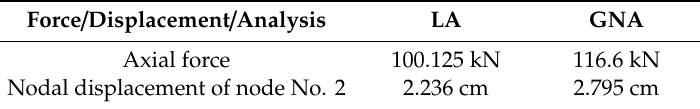
Table 2. Values of axial force and nodal displacement.